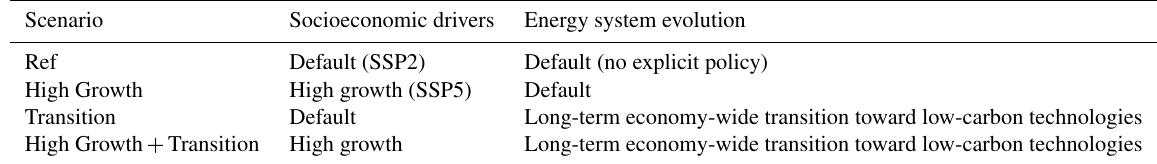
Table 1. Scenario design Scenario Socioeconomic